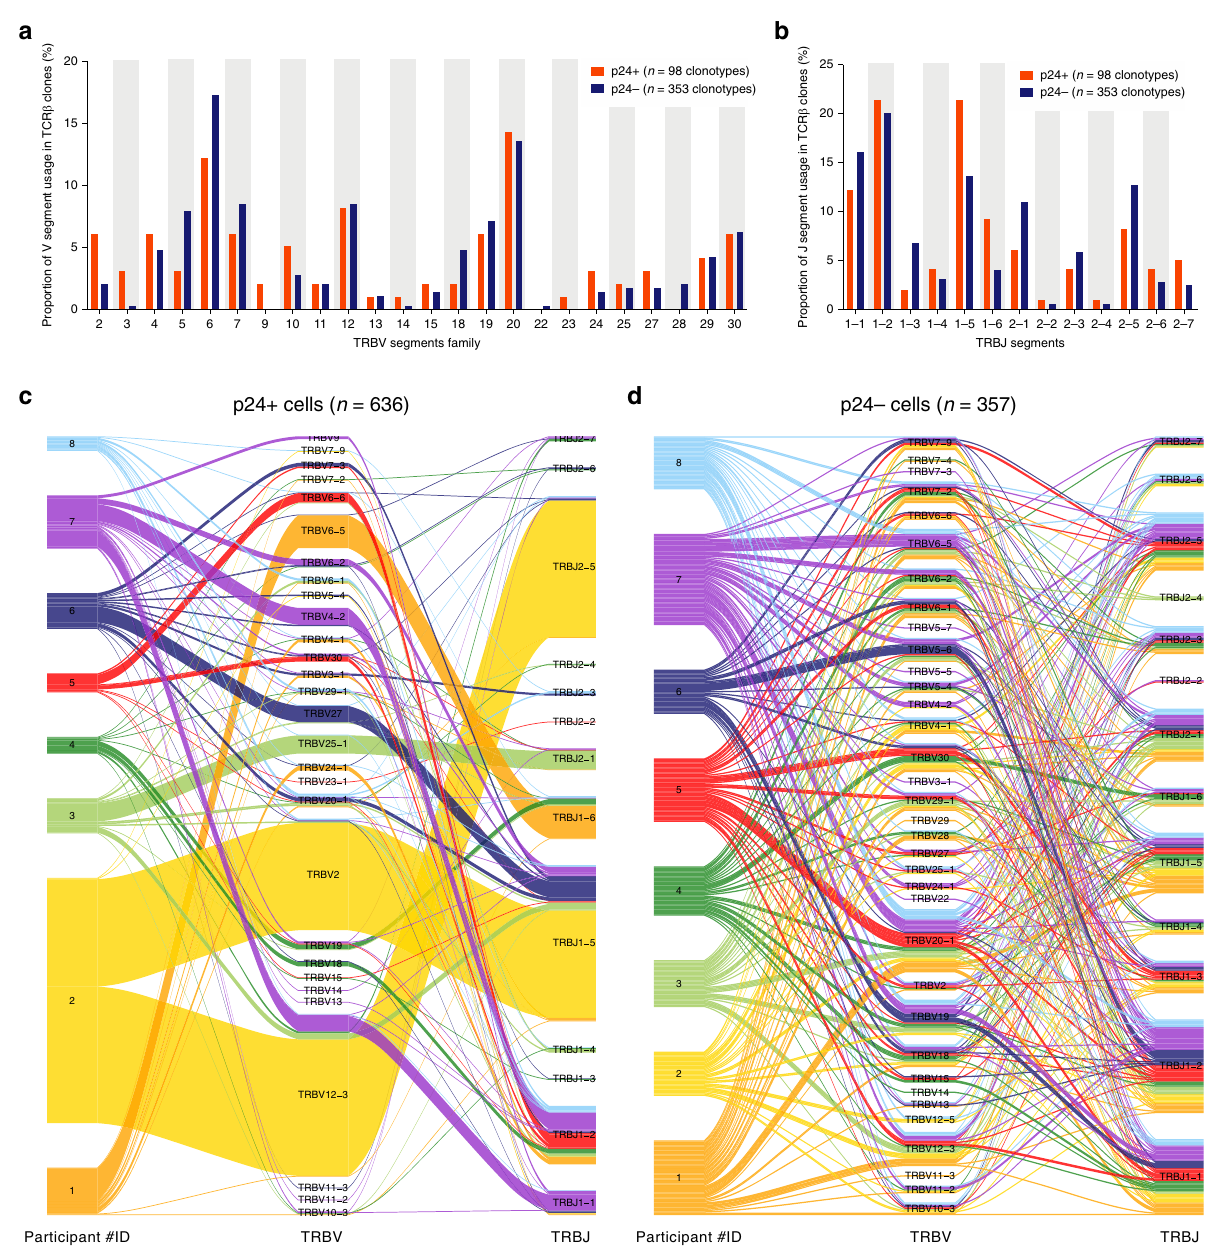
Fig. 2 The bias in the TCR repertoire of the translation-competent reservoir is due to clonal expansion. a , b Frequency of TRBV ( a ) and TRBJ ( b ) segment usage for the clonotypes identi fi ed by TCR β sequencing in p24 + cells (red bars, n = 98 clonotypes) and p24 − cells (blue bars, n = 353 clonotypes). c , d Association between the TRBV and TRBJ segments in individual p24 + ( n = 636, c ) and p24 − ( n = 357, d ) cells from all participants (depicted by different colors). Connecting lines between the last two columns represent the number of individual associations. Large connecting lines denote a bias in the TCR repertoire. Source data are provided as a Source Data fi